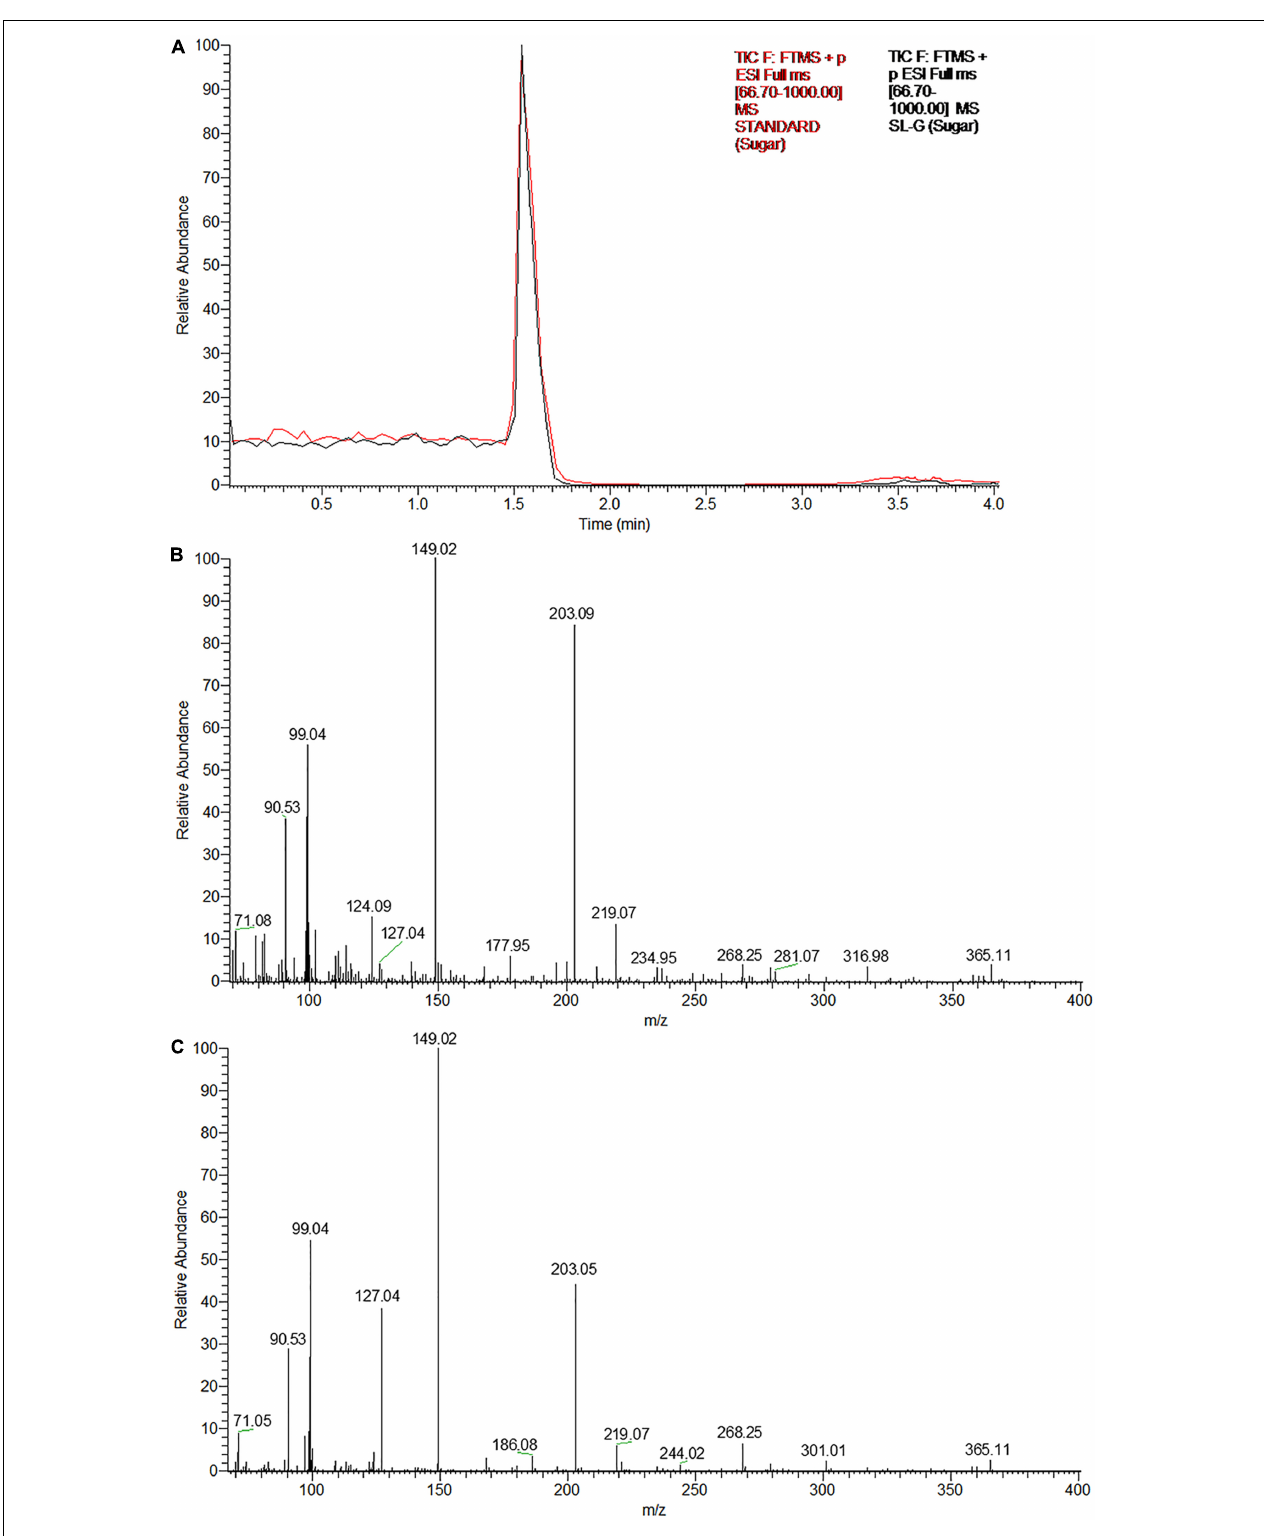
FIGURE 3 | The glycan part of the biosurfactant produced by R. babjevae YS3 (SL-YS3) is sophorose. (A) UPLC chromatogram (TIC) of the sugar component of the sophorolipid under study (SL-YS3, black) in comparison with that of the standard sophorolipid (SL-S, red). The single peak with the same retention time (Rt) indicates the same sugar composition of SL-YS3 and SL-S. The positive ESI-MS spectra of (B) SL-S and (C) SL-YS3 exhibited sodiated adducts of glucose monomer [M + Na] + and dimer [2M + Na-H 2 O] + at m/z 203 and m/z 365 respectively.